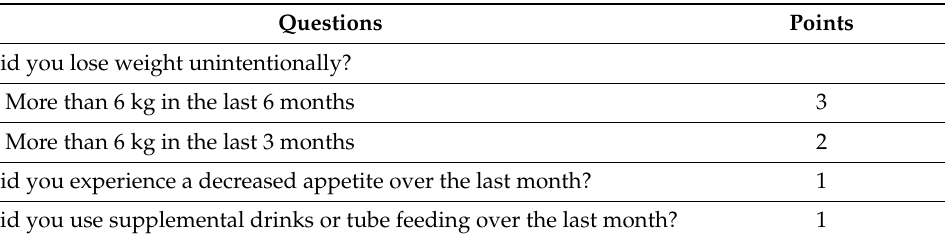
Table 1. Simplified Nutritional Appetite